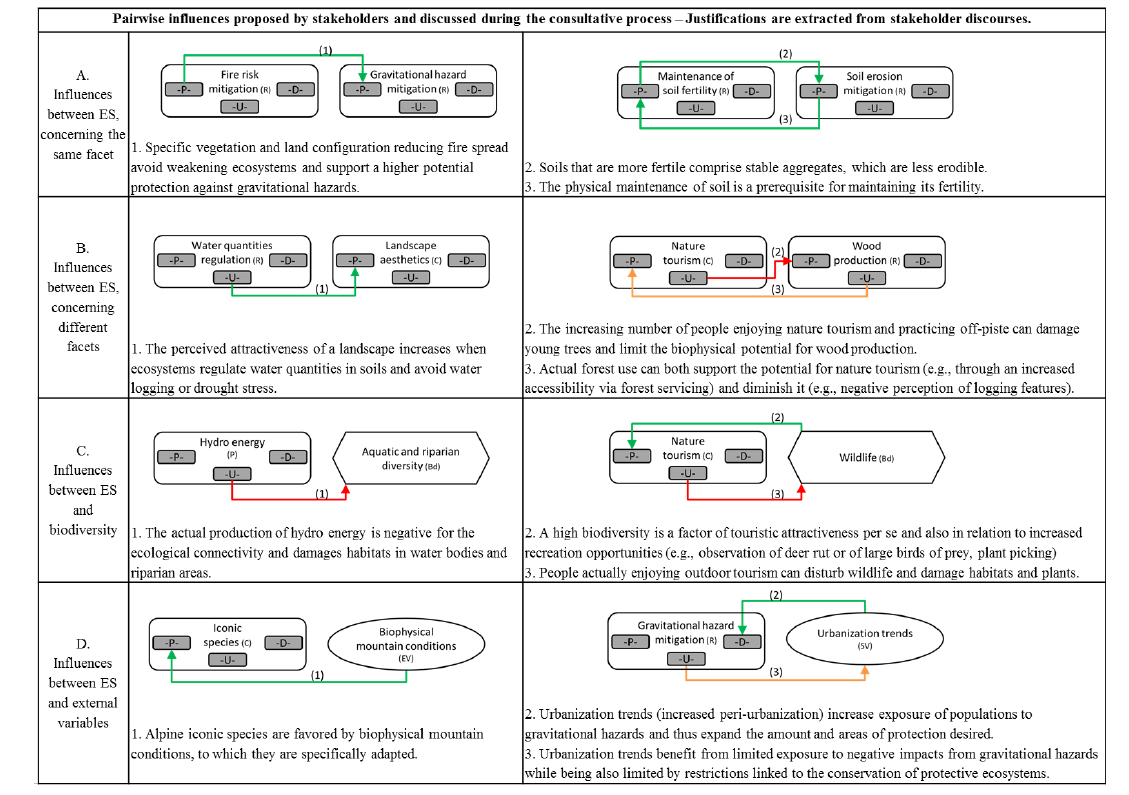
Fig. 4 . Examples of pairwise influences concerning alpine ecosystem services (ES), as perceived by stakeholders during the consultative process, picked from the influence matrix of our case study (Appendix 2). Diagrams represent influences between ES, within the same facet (A) and among facets (B), between ES and biodiversity (C), and between ES and external variables (D). Influences are either unilateral (influence 1, left column) or mutual (influences 2 and 3, right column) and concern all variable categories: provisioning ES (P), cultural ES (C), regulating ES (R), biodiversity (Bd), social variables (SV), and ecological variables (EV). Green arrows represent a positive influence, red arrows a negative influence, and orange arrows describe influences with either positive and negative aspects, or varying